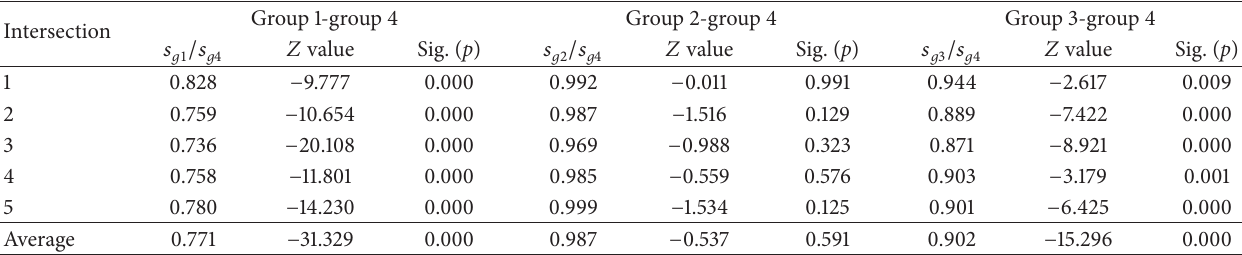
Table 4: Multiple comparisons of the headway (Mann–Whitney test).